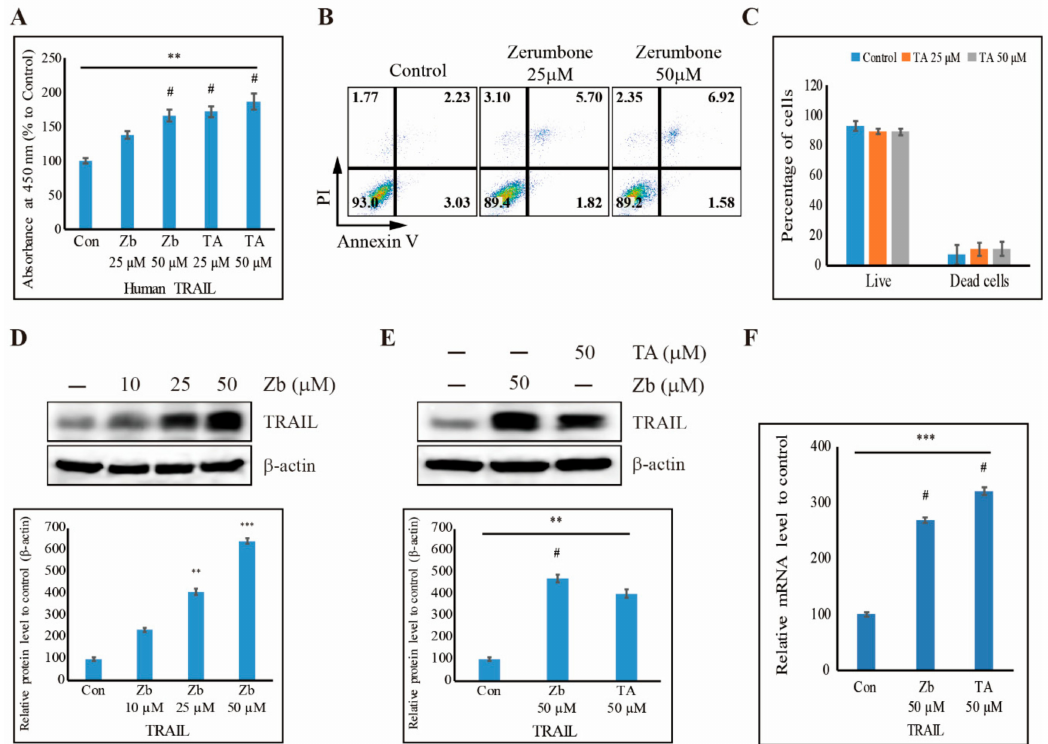
Figure 7. TA induces human tumor necrosis factor-related apoptosis-inducing ligand (TRAIL) expression. ( A ) Human TRAIL assay showing the elevation of human TRAIL with zerumbone (Zb) and TA treatment for 48 h. Control is set to 100. ** p < 0.01 (ANOVA test). # The mean di ff erence